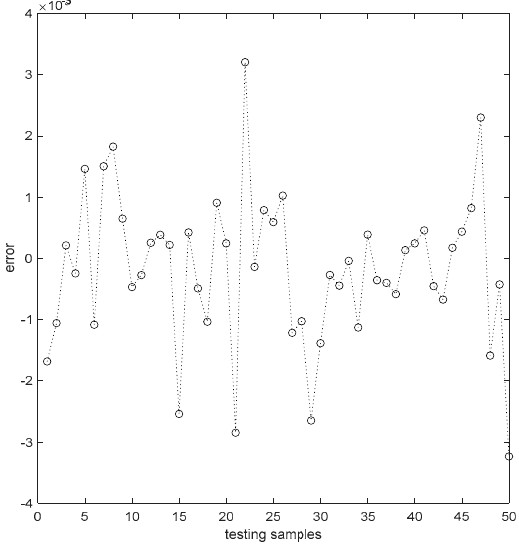
Figure 7. Network prediction error.